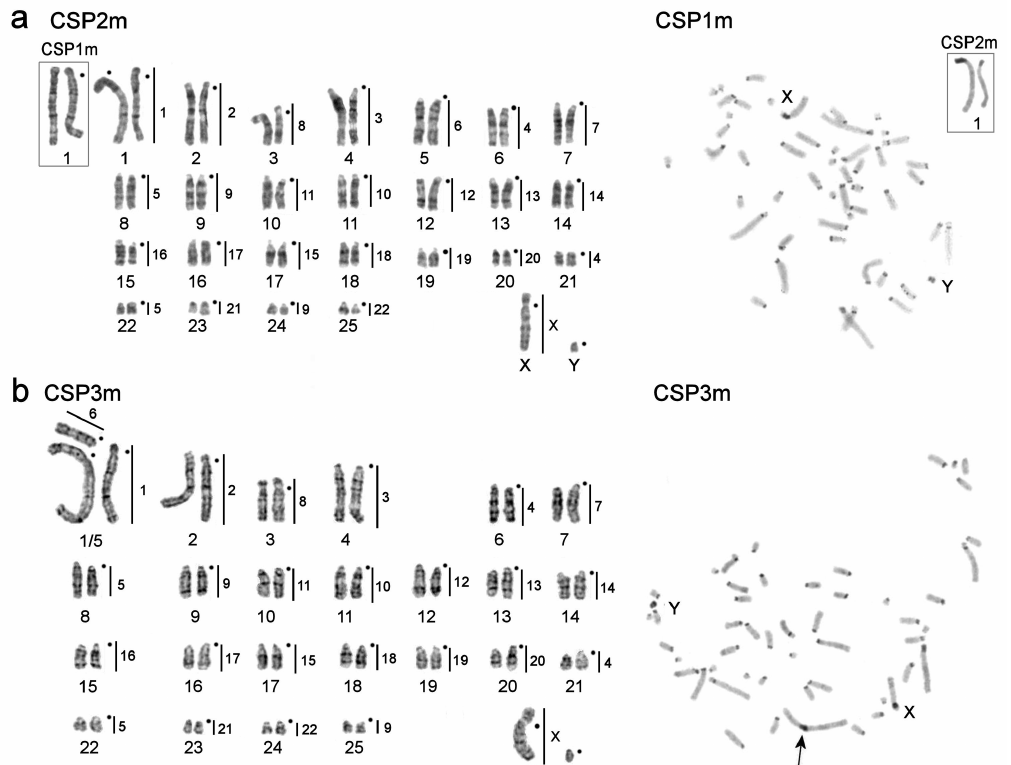
Figure 4. G-banded karyotypes (on the left) and C-banded metaphases (on the right) of the studied specimens with 2n = 51–52 and FNa = 56–57: ( a ) Calomyscus sp. 1m (CSP1m) and Calomyscus sp. 2m (CSP2m, corrected karyotype from Romanenko et al. [45], published as “ Calomyscus sp. 1” in [46]) with 2n = 52, FNa = 5 6; ( b ) Calomyscus sp. 3m (CSP3m) with 2n = 51, FNa = 57 , vertical black lines and figures on the right of G-banded chromosomes show localization of Calomyscus sp. 17m (CSP17m) probes. Black dots mark the position of centromeres. In C-banding photos the black arrow indicates a pericentromeric heterochromatin segment in the largest chromosome and sex chromosomes (X and Y) are shown.